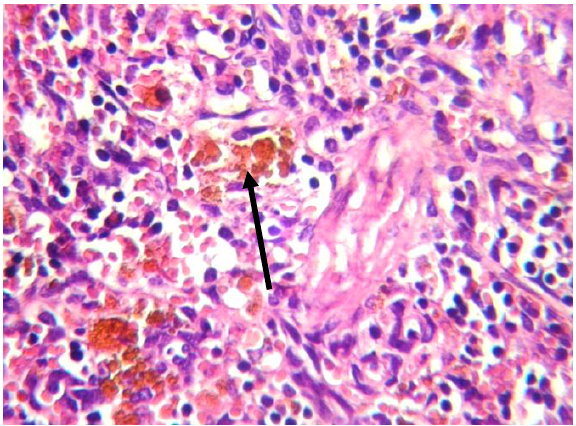
Fig 24: Microscopic section of spleen from third group during 24 – 48 hrs. post challenge show severe congestion and dilation of vascular sinuses of red pulp with PMNCs infiltration (H&E X20).